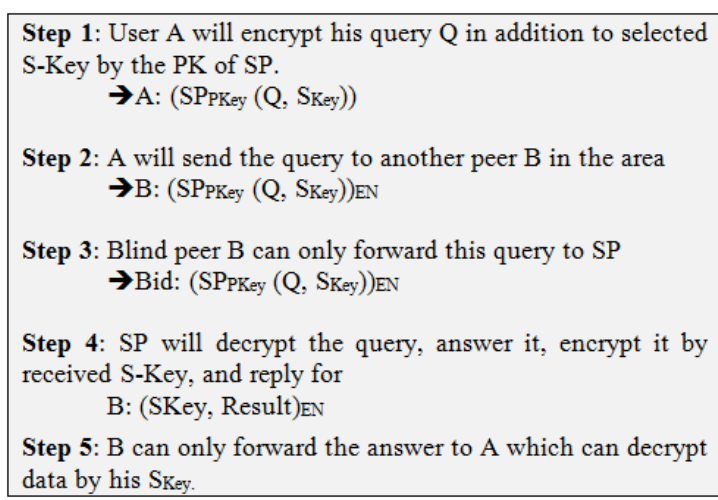
Figure 10. Blind Peer Technique ( B L P ).